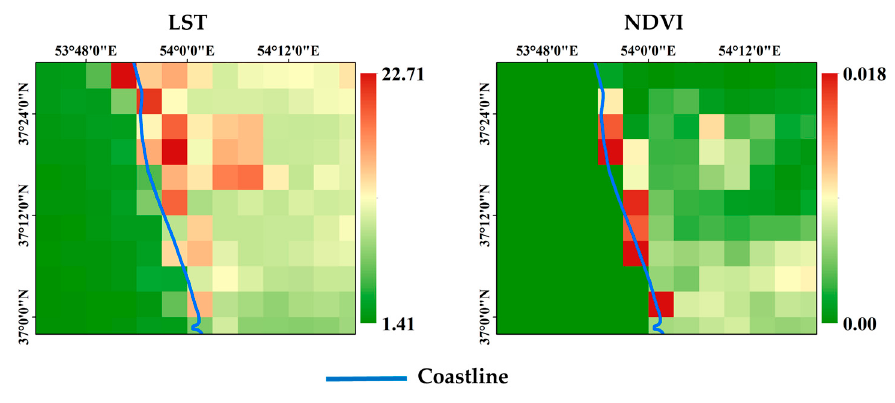
Figure 8. Annual variance maps of LST and NDVI.